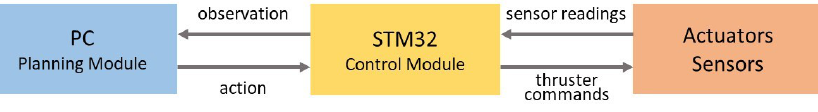
Figure 6. Framework